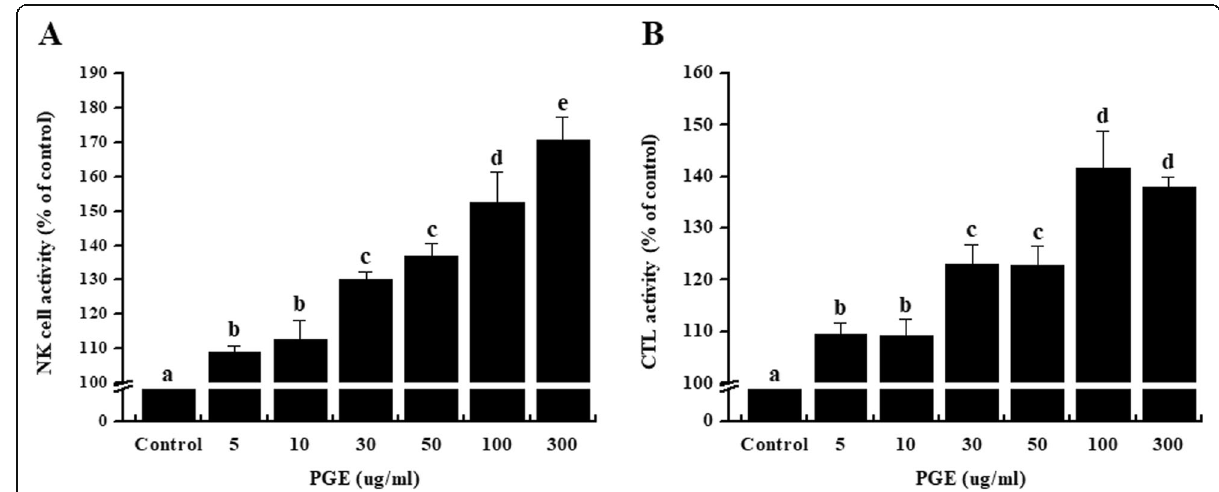
Fig. 5 Effect of PGE on splenic NK cell and CTL cytotoxicity in splenocytes. Splenocytes were prepared and assayed for NK cell ( a ) and CTL ( b ) activity using the WST-1 assay. Splenocytes were co-cultured with target cells (AR42J or HL-60) for NK cell or CTL activity, respectively, in 96-well plates, followed by treatment with PGE (0, 5, 10, 30, 50, 100, and 300 μ g/mL) and incubated for 24 h in a 5% CO 2 incubator with an effector to target cell ratio of 25:1. NK cell and CTL activities were calculated as the survival rate of AR42J or HL-60 cells compared to that of control cells. Bars labeled with different superscripts have significantly different values ( P < 0.05). Data are presented as the means ± standard error ( n = 3)